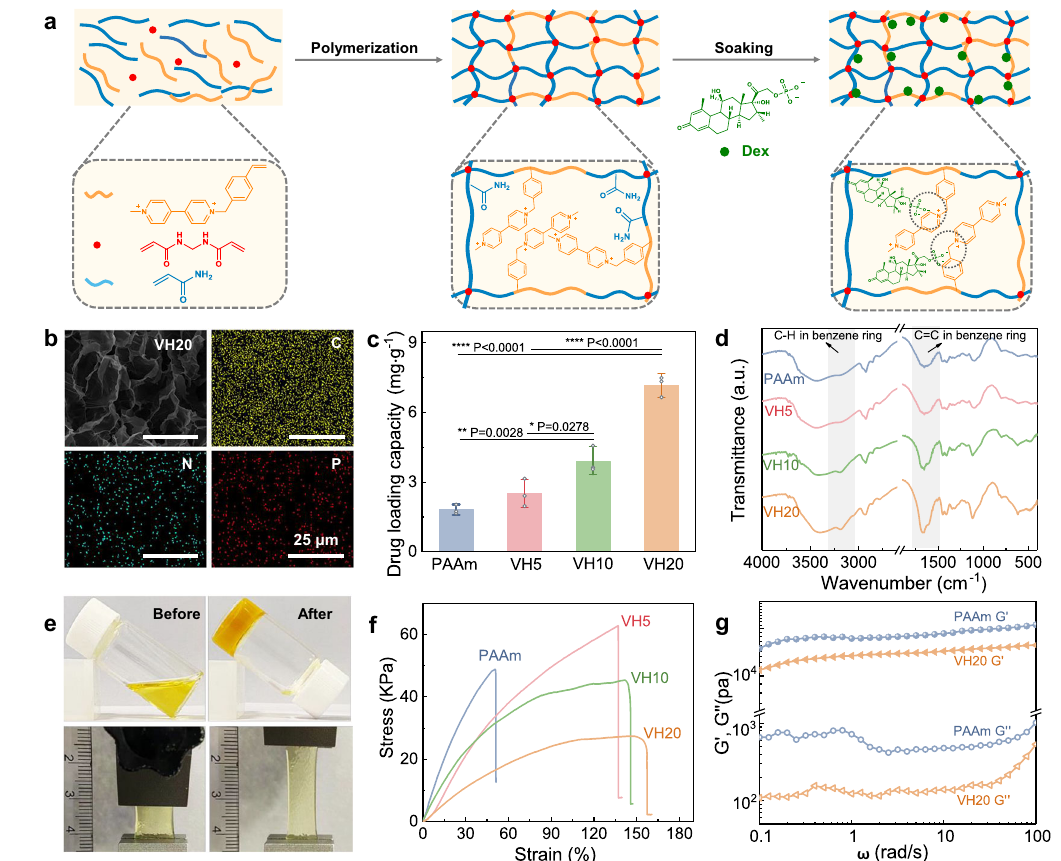
Fig. 1 | Preparation and characterizations of P(AM-co-SV) hydrogels. a Schematic illustration of the synthesis, molecular structures, and interactions of drug-loaded P(AM-co-SV) hydrogels. b Scanning electron microscopy (SEM) and corresponding EDSimages of the Dex-loaded VH20 hydrogel.Measurements were repeated three times independently with similar results. c Loading capacity of P(AM-co-SV) hydrogels ( n =3 independent experiments, data are presented as mean±SD, * P <0.05, ** P <0.01, *** P <0.001, **** P <0.0001, ns for no signi fi cance,